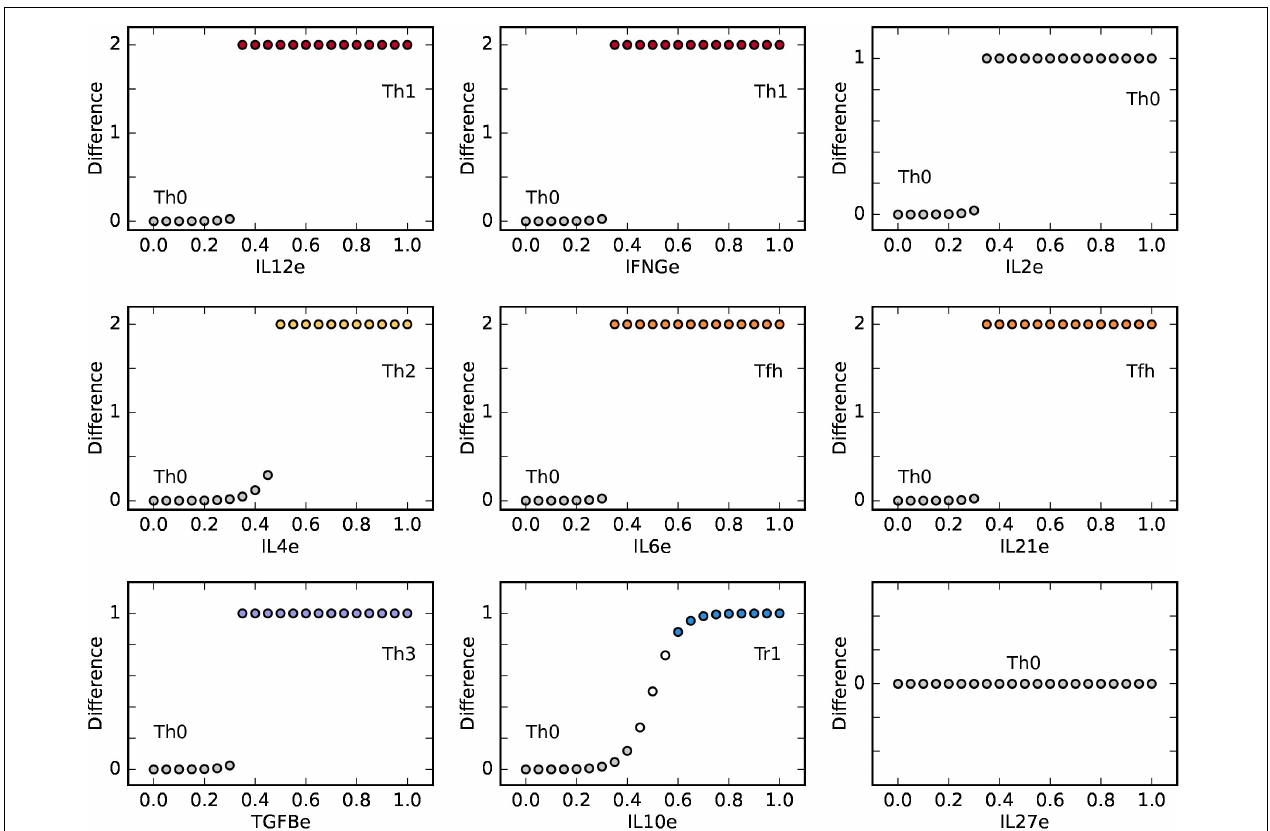
FIGURE 3 | CD4+ T cell fate as a function of the concentration of single exogenous cytokines: IL12, IFNG, IL2, IL4, IL6, Il21, TGFB, IL10, and IL27. From an initial state TH0, a CD4+ T cell may acquire diverse phenotypes on an abrupt or gradual transition, depending on critical concentrations of environmental cytokines. The plot shows the difference between the values of the initial Th0 state and the final steady state at different concentrations of exogenous cytokines. We observe that the presence of either IL12 or IFNg is sufficient for Th1 polarization, as well as IL4, is sufficient for TH2 polarization. On the other hand, IL2 alone does not lead to an effector phenotype. Similarly, the presence of either IL6 or IL21 alone is sufficient for Tfh induction, as is the case of TGFB and IL10, leading to Th3 and Tr1, respectively. IL27 alone does not lead to any fate transition in this